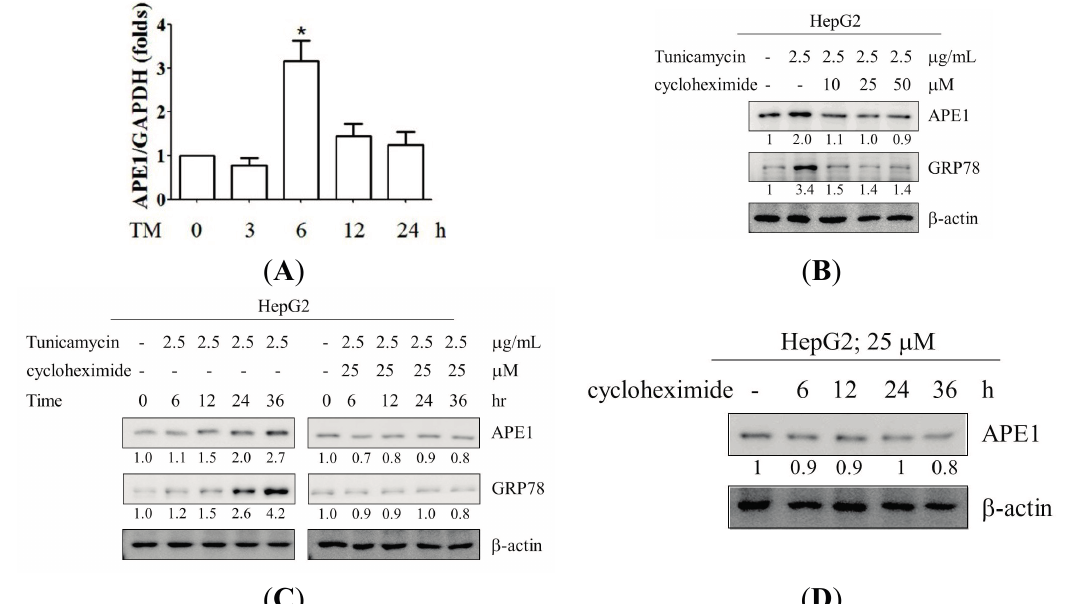
Figure 2. Induction of APE1 mRNA expression by tunicamycin (TM) was determined by real-time PCR in HepG2 cells ( A ). The cells were exposed with 2.5 μ g/mL tunicamycin for times indicated. The total RNA was isolated and then subjected to real-time PCR analysis. Real-time PCR was performed as described in the Experimental Section. Columns , mean of three independent experiments; bars, SD ( * , p < 0.05, Student’s t test); ( B , C ) Induction of APE1 expression by tunicamycin was inhibited by CHX in HepG2 cells. The cells were exposed with 2.5  g/mL tunicamycin in the presence of CHX for as dose and time-indicated. The expression of APE1, GRP78 and β -actin were analyzed by Western blotting. The expression levels of APE1 and GRP78 were quantified by using ImageJ software; ( D ) HepG2 cell were treated with CHX for 6, 12, 24, and 36 h. The cell lysates were analyzed by western blotting with antibodies for APE1 and β -actin. The expression level of APE1 was quantified by using ImageJ